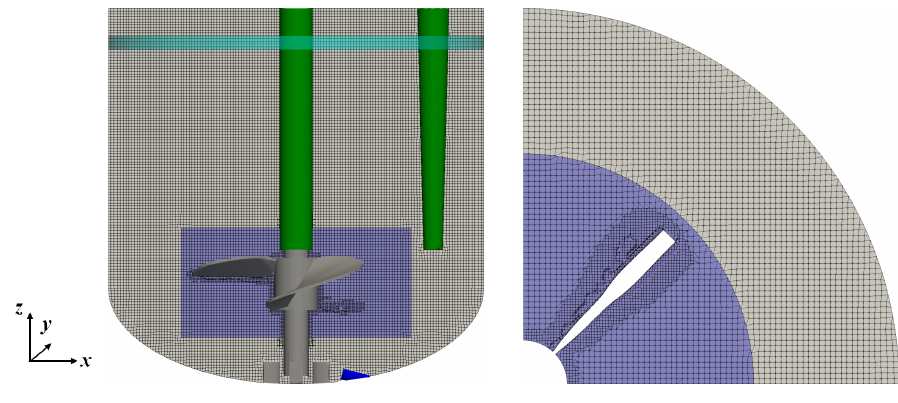
Figure 2. Computational grid for the liquid phase for the working volume of 1.7